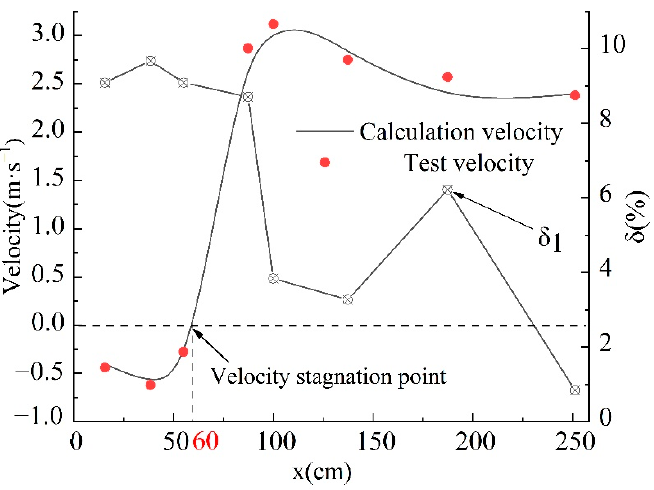
Figure 7. Comparison of bottom